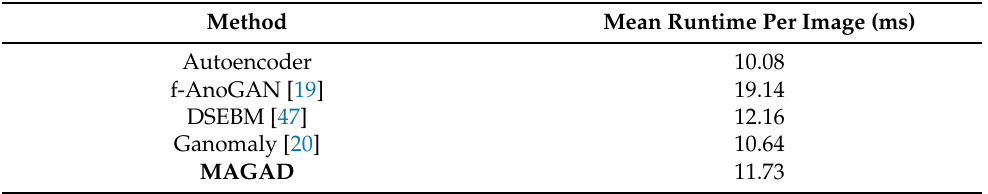
Table 5. Runtime test of five